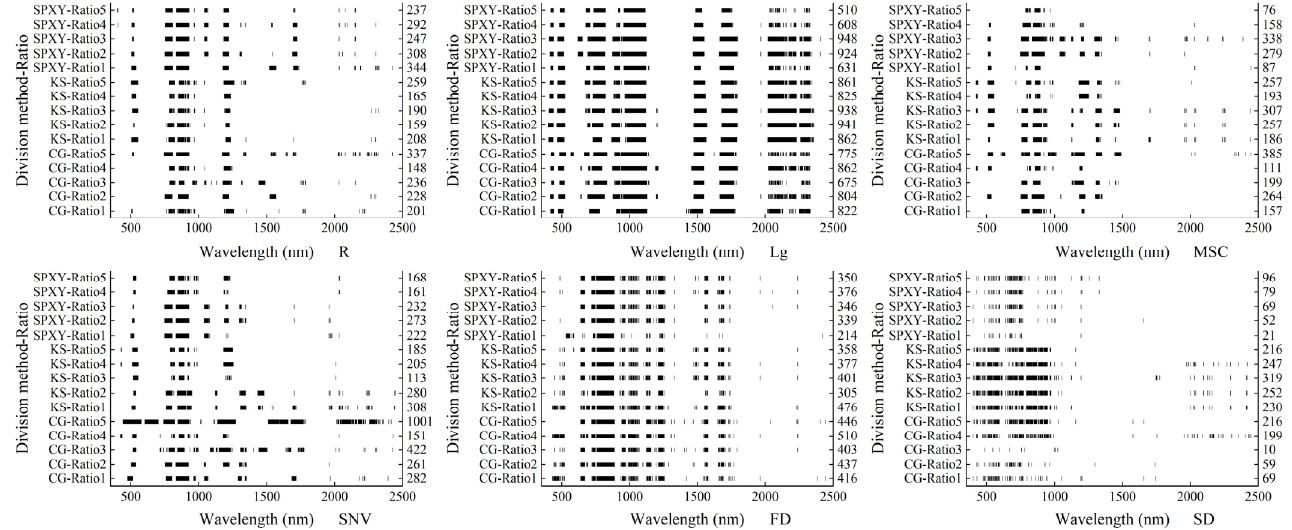
Figure 5. Band-screening results of UVE under different preprocessing algorithms. Note: The number on the right is the number of bands; the same is true below.